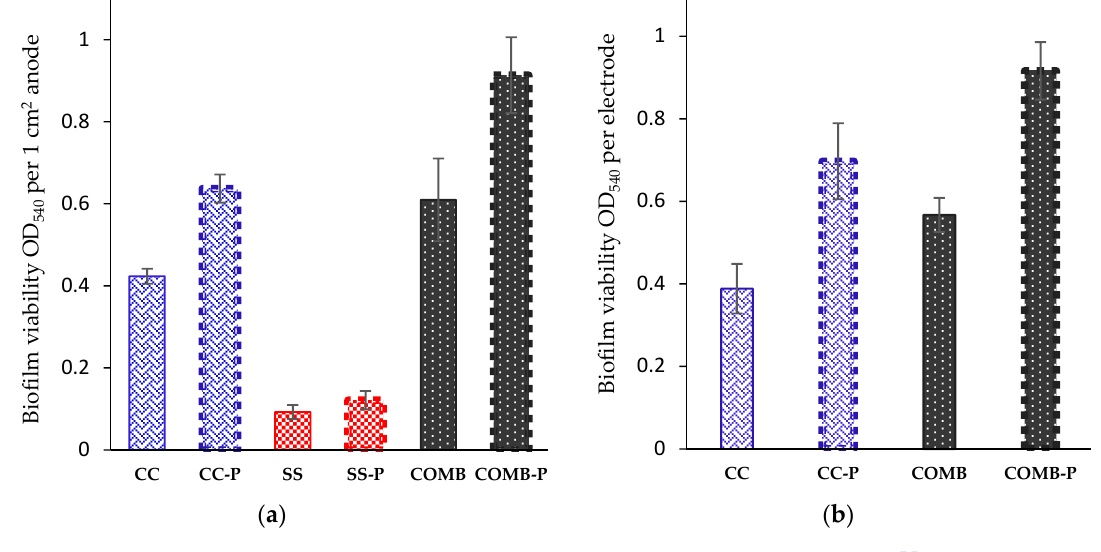
Figure 4. MTT analysis of biofilm viability on different anode materials CC ( ), CCP ( ), SS ( ), SSP ( ), COMB ( ), COMBP ( ): ( a ) before MEC operation, per 1 cm 2 anode; ( b ) after MEC operation, per electrode.